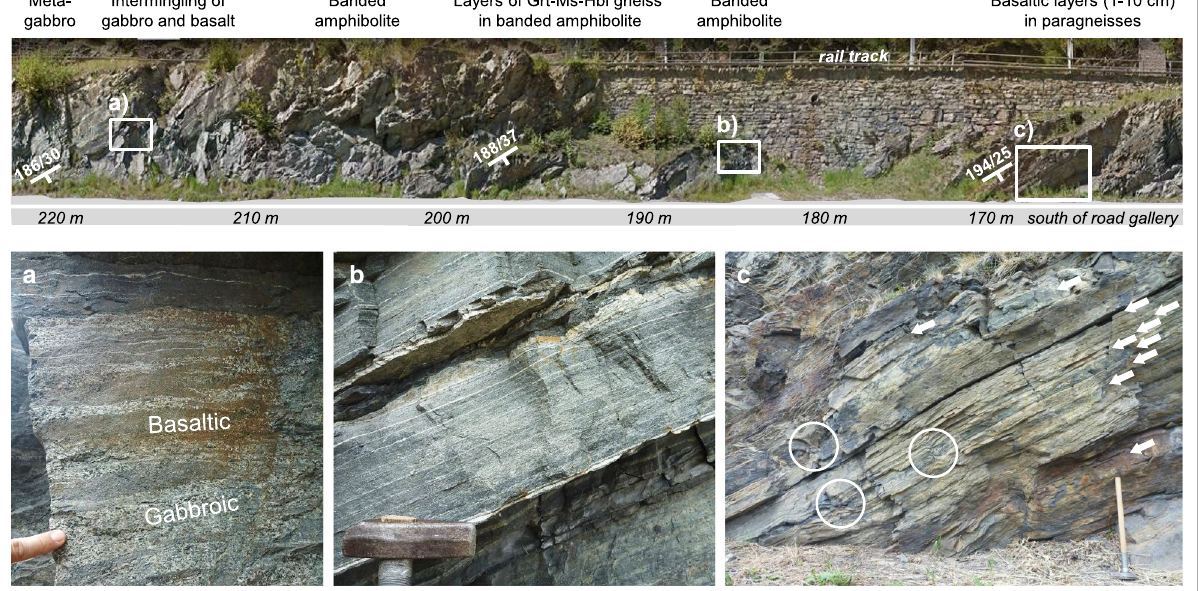
Table 2 Square km and area percentages per main lithology from the different pre‑Variscan gneiss units Aar